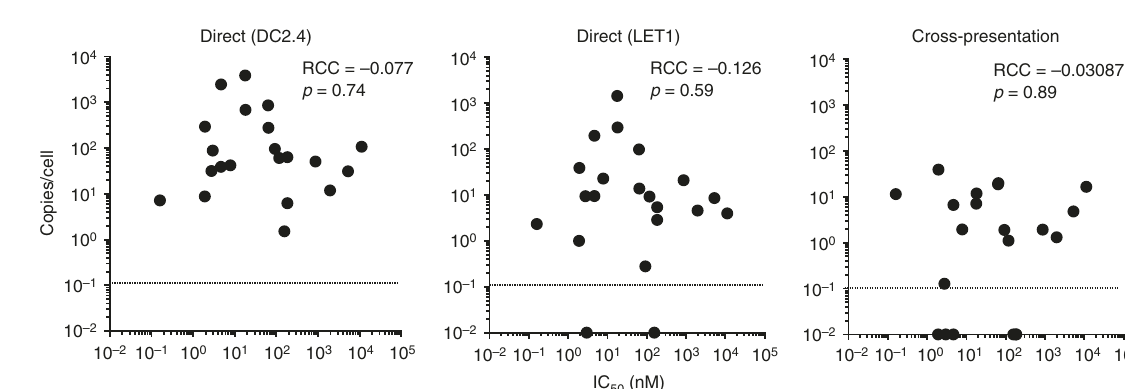
Fig. 4 Correlation of peptide-MHCI binding af fi nity and epitope abundance. The mean peptide abundance as determined following direct infection of DC2.4 cells or LET1 cells or via A549 × Mutu cross-presentation was correlated with the mean IC 50 of each bound peptide, showing the Spearman ’ s rank correlation coef fi cient (RCC) and associated p values